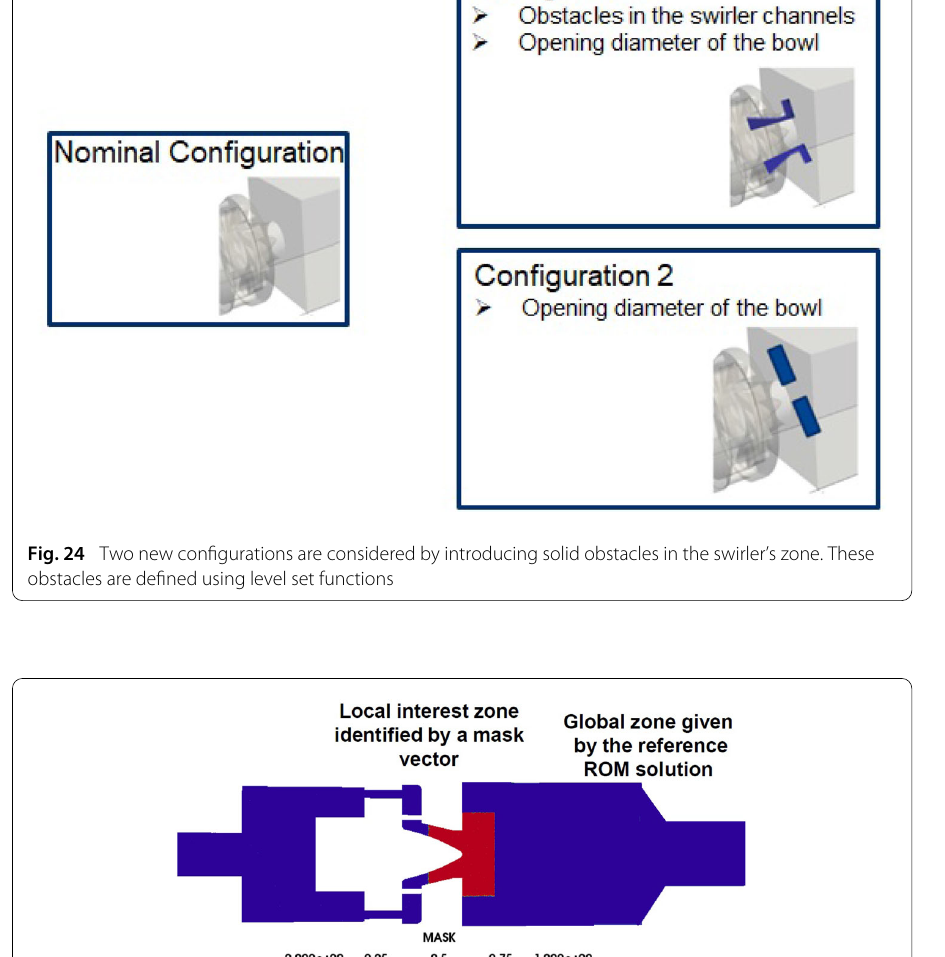
case 3 . 5 h on 128 cores. We have a very important reduction in the CPU time needed for this local LES with respect to the complete LES, as a consequence of the reduction of the computation domain. (cid:2) \ (cid:2) R is defined by the reference reduced order velocity field associated with the reference configuration, which has been saved on a coarser grid for this region. We finally point out the fact that the pressure field is computed all over the fluid domain by the HF solver, because our reference dissipative reduced order model does not contain the pressure field. The pressure computation in the hybrid simulation is efficient as we did a derefinement step by 40% for the reference dissipative velocity modes in (cid:2) \ (cid:2) R in blue, see Fig. 25. In other words, the dissipative velocity modes, see Figs. 12, 13, 14, 15, 16, 17, 18, 19, 20, 21, 22 and 23, are saved on a coarser grid in the blue zone of Fig.